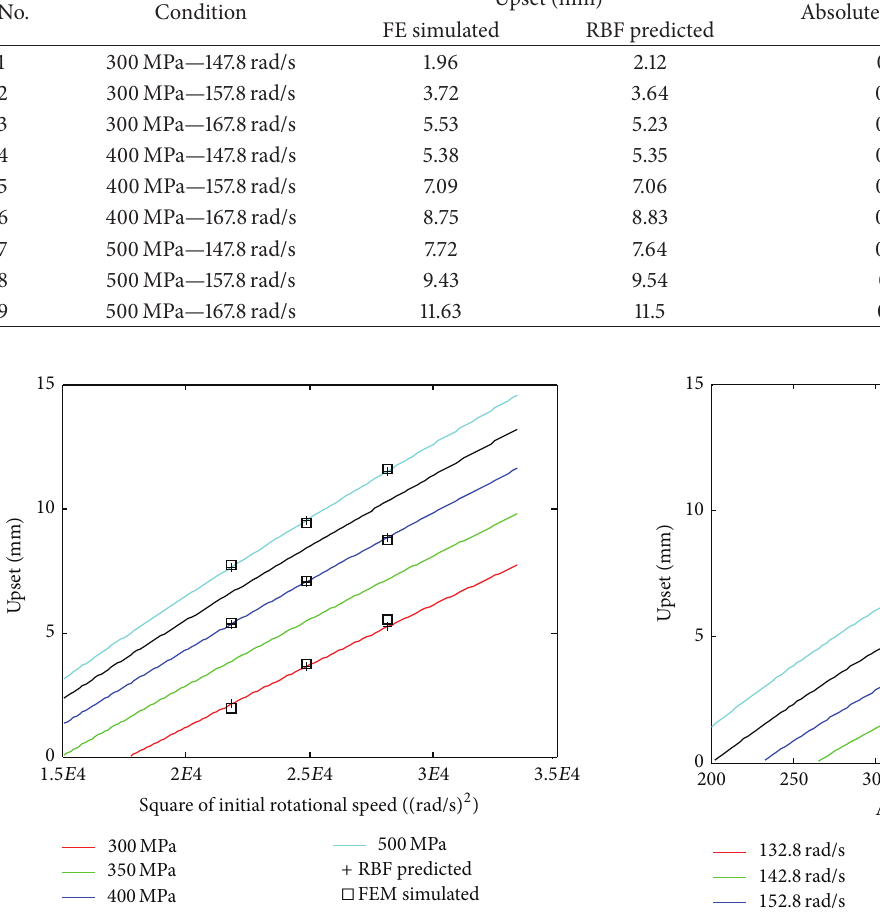
Figure 9: Effect of axial pressure on upset predicted by RBF